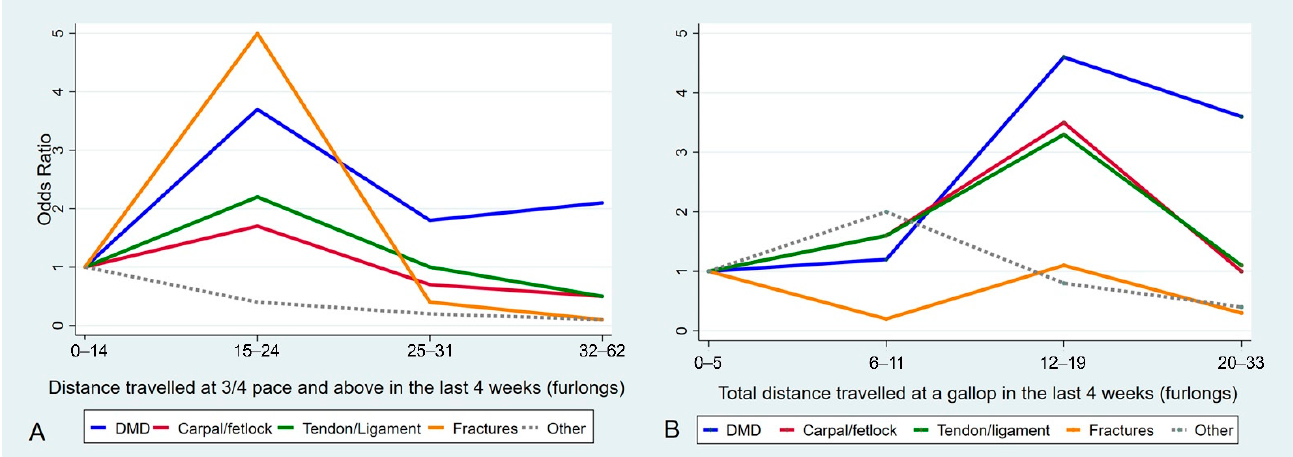
Figure A5. The effect of increasing distance travelled at three-quarter pace (faster than 13 m/s; 15 s/furlong; 800 m/min; 48 km/h) ( A ) and the total distance travelled at a gallop (faster than 15 m/s; 13 s/furlong; 900 m/min; 55 km/h) ( B ) on musculoskeletal injury in Thoroughbred racehorses in South-East Queensland, Australia. Results shown are from a univariable conditional logistic regression analysis for 202 cases of musculoskeletal injury and 202 controls matched by trainer and age, analysed by broad categories of injuries.